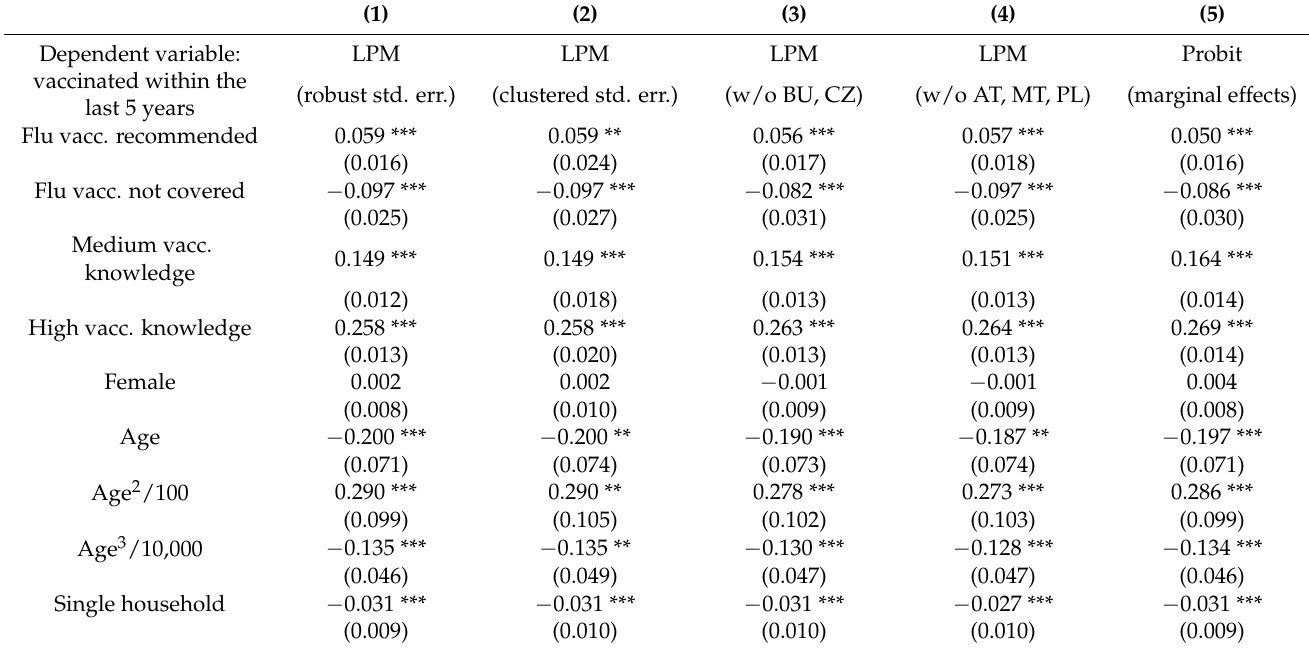
Table 3. Estimation